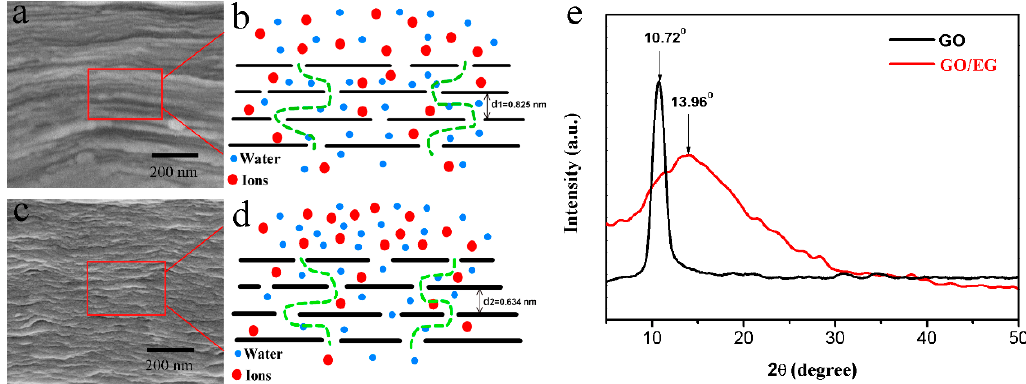
Figure 7. ( a,c ) FESEM images of the cross section of GO and GO/EG composite membrane, ( b,d ) Schematic diagram for the permeation through GO and GO/EG membrane laminates, ( e ) The XRD pattern of GO and GO-EG composite.